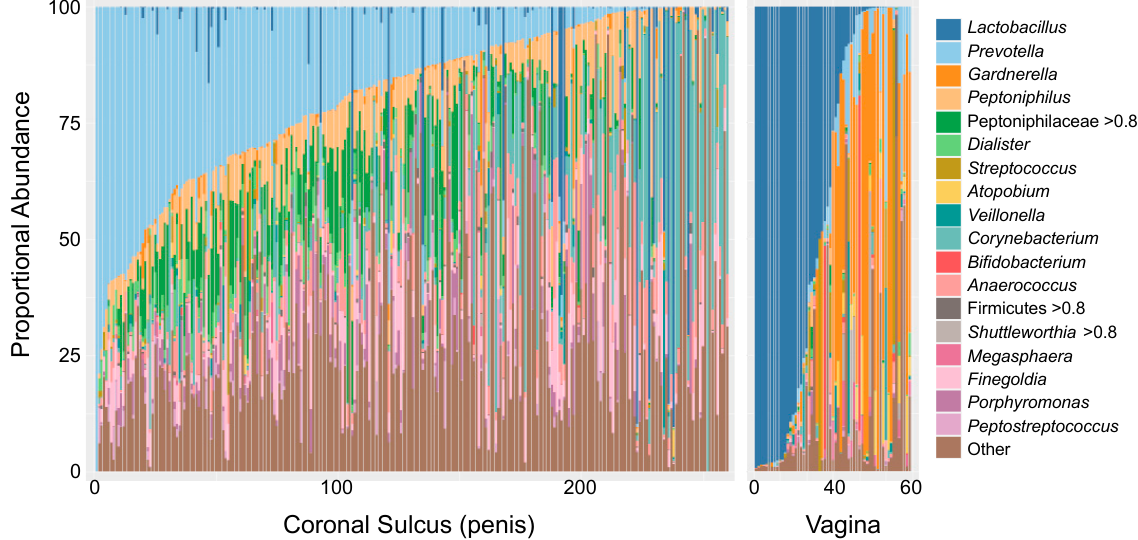
Figure 1. Proportional abundances of the 18 most prevalent taxa on the coronal sulcus of the uncircumcised penis ( n = 260 [119]) and in the vagina ( n = 60 [147]) of Rakai Cohort participants. Participants of each sex are ordered based on the abundance of the most prevalent taxa at that site: Prevotella on the coronal sulcus and Lactobacillus in the vagina.